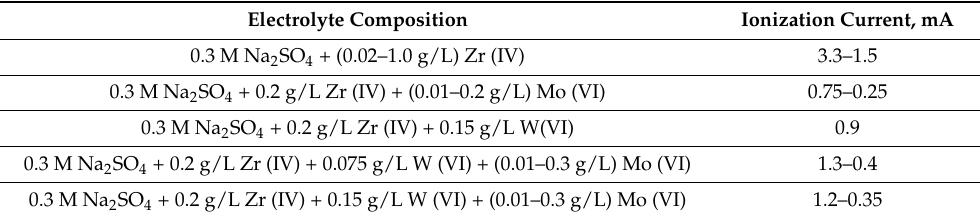
potential of − 0.3